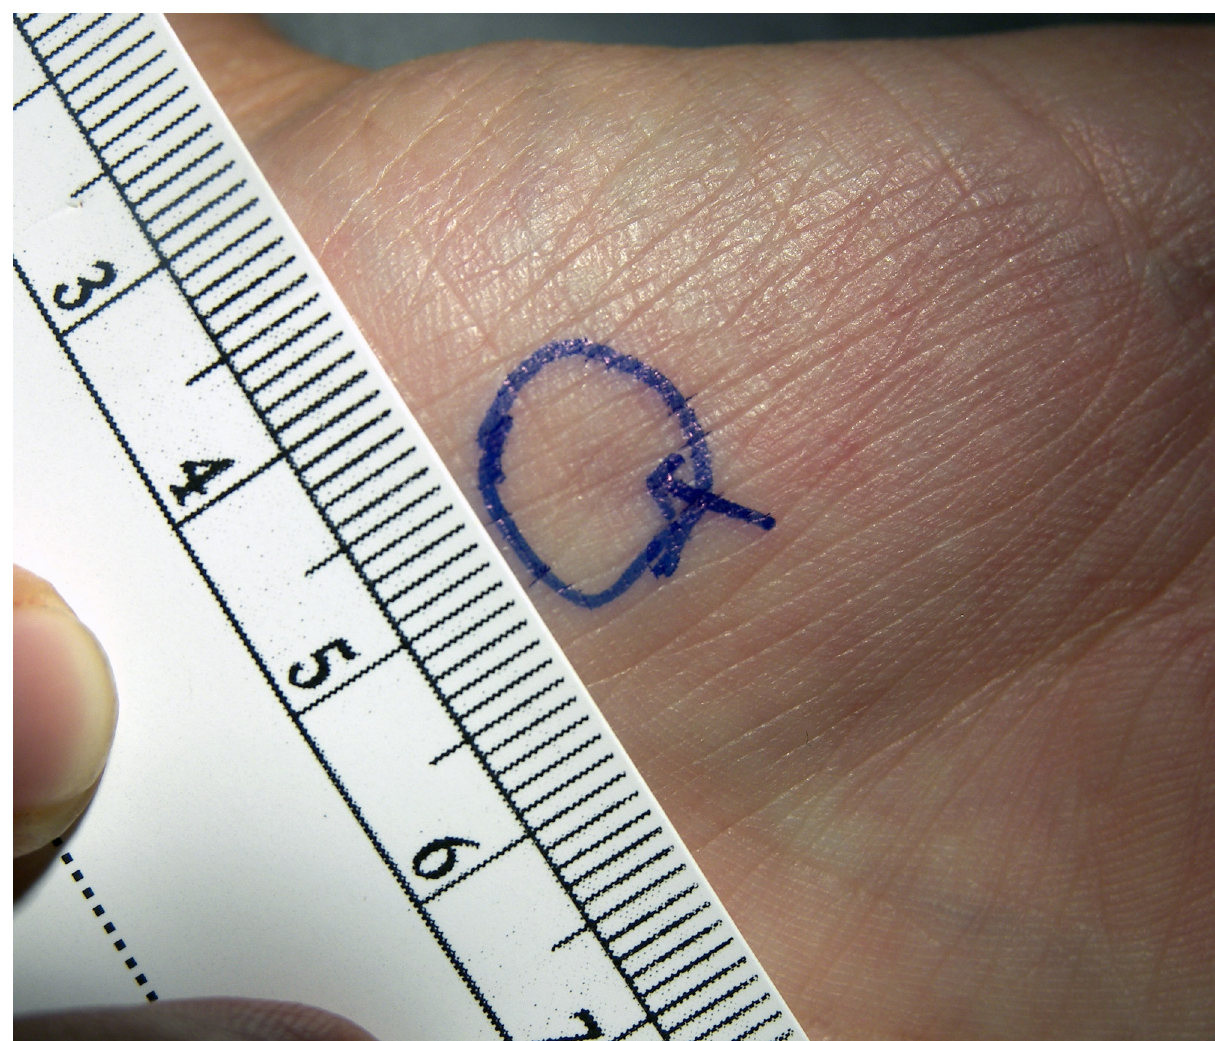
Figure 2 . Sting site at the time the patient was discharged from hospital. The circle indicates the maximum area of the redness while the arrow shows the point at which the aculeus penetrated the skin (photo by M.